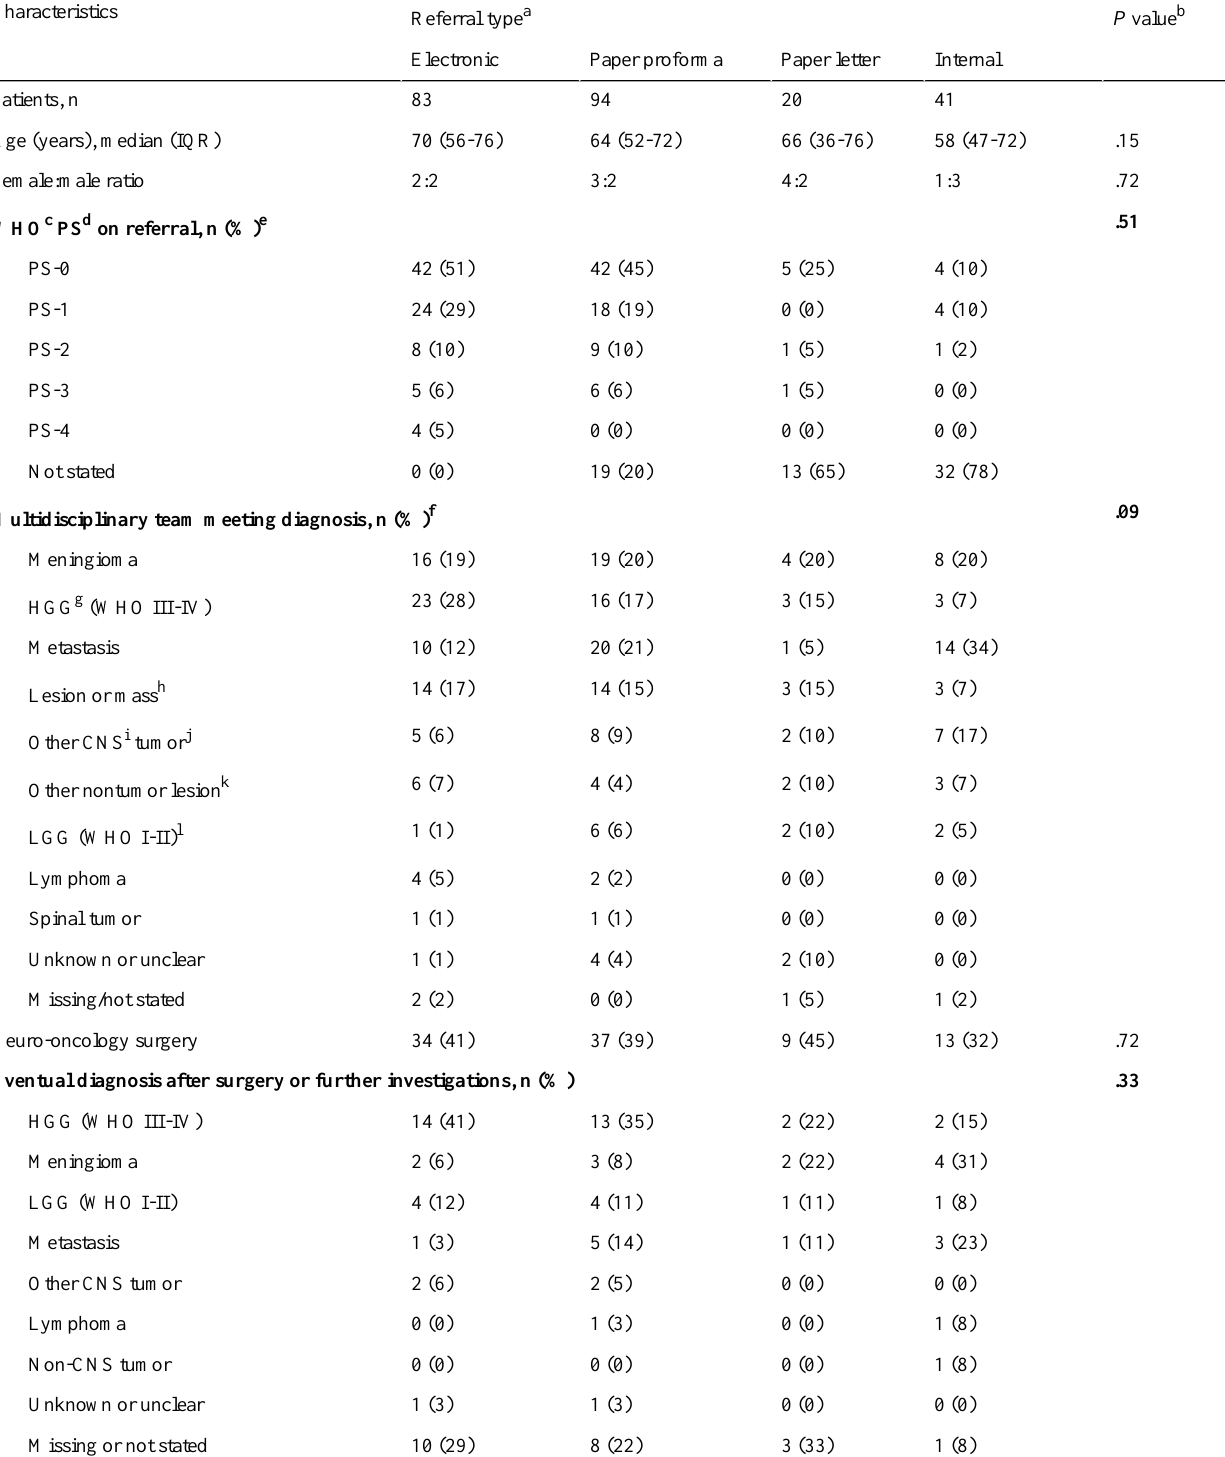
Table 1. Characteristics of patients referred to the study neuroscience centers by referral type excluding unknown and unusual referral pathways.